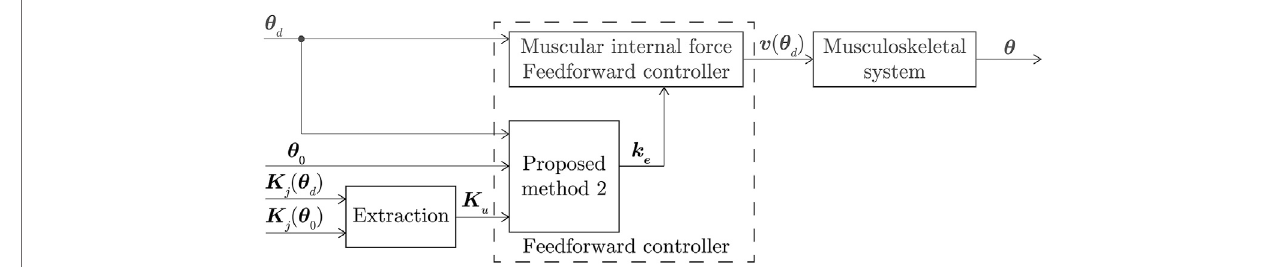
FIGURE 7 | Block diagram of application of Method 2 using MIF controller.